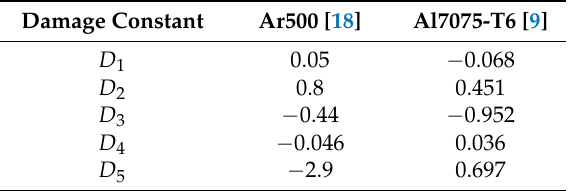
Table 2. Johnson–Cook fracture model constants for target